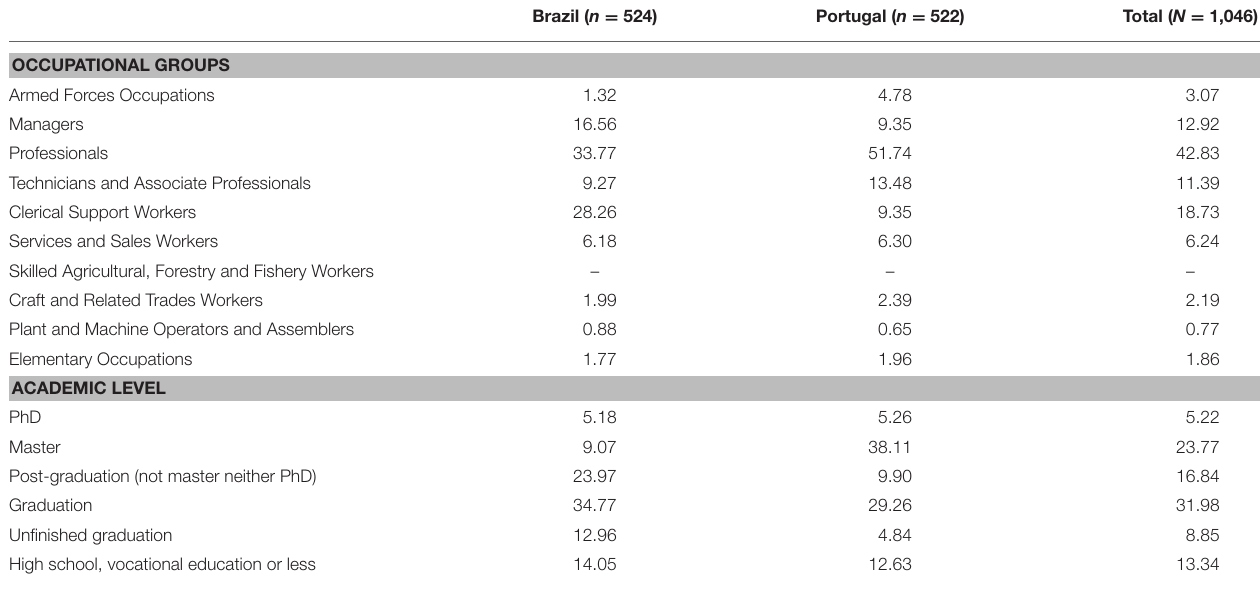
TABLE 2 | Percentage of occupational groups for each country and